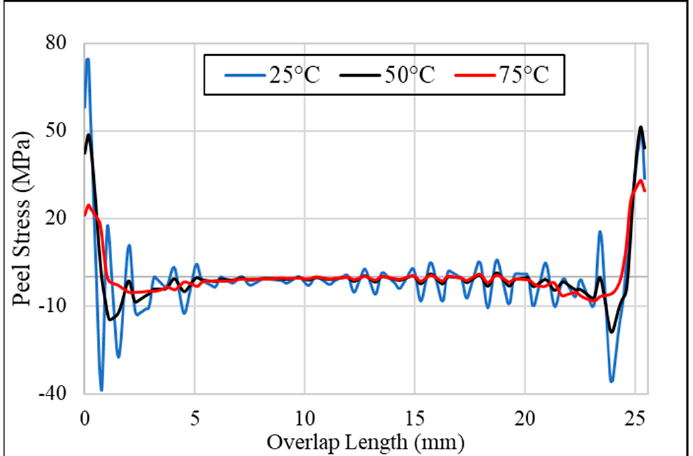
Figure 7. Peel stress distribution at location B of SLJ with neat adhesive at different temperatures.